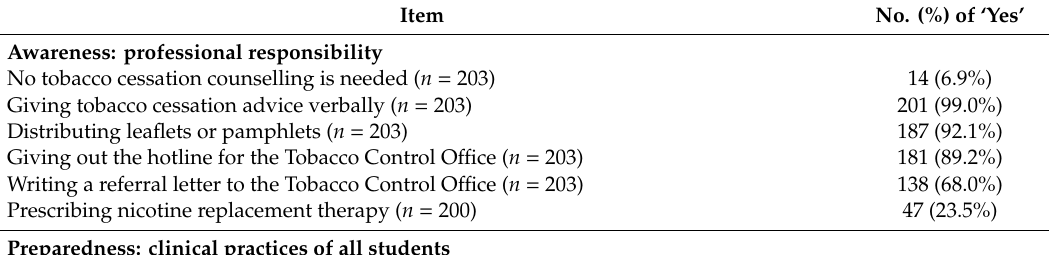
Table 3. Dental students’ awareness on professional responsibility items and clinical practices towards tobacco cessation counselling